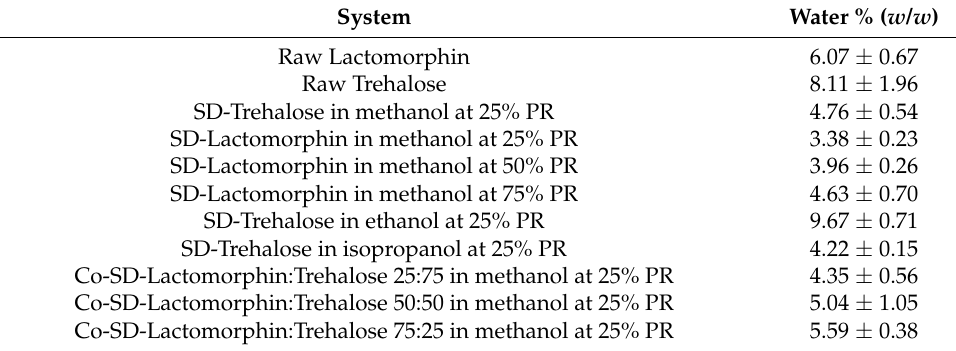
Table 4. Residual water content of SD-Lactomorphin, SD-Trehalose, co-SDLactomorphin:Trehalose powder systems and their raw counterparts analyzed by Karl Fisher coulometric titration (mean ± standard deviation, n =